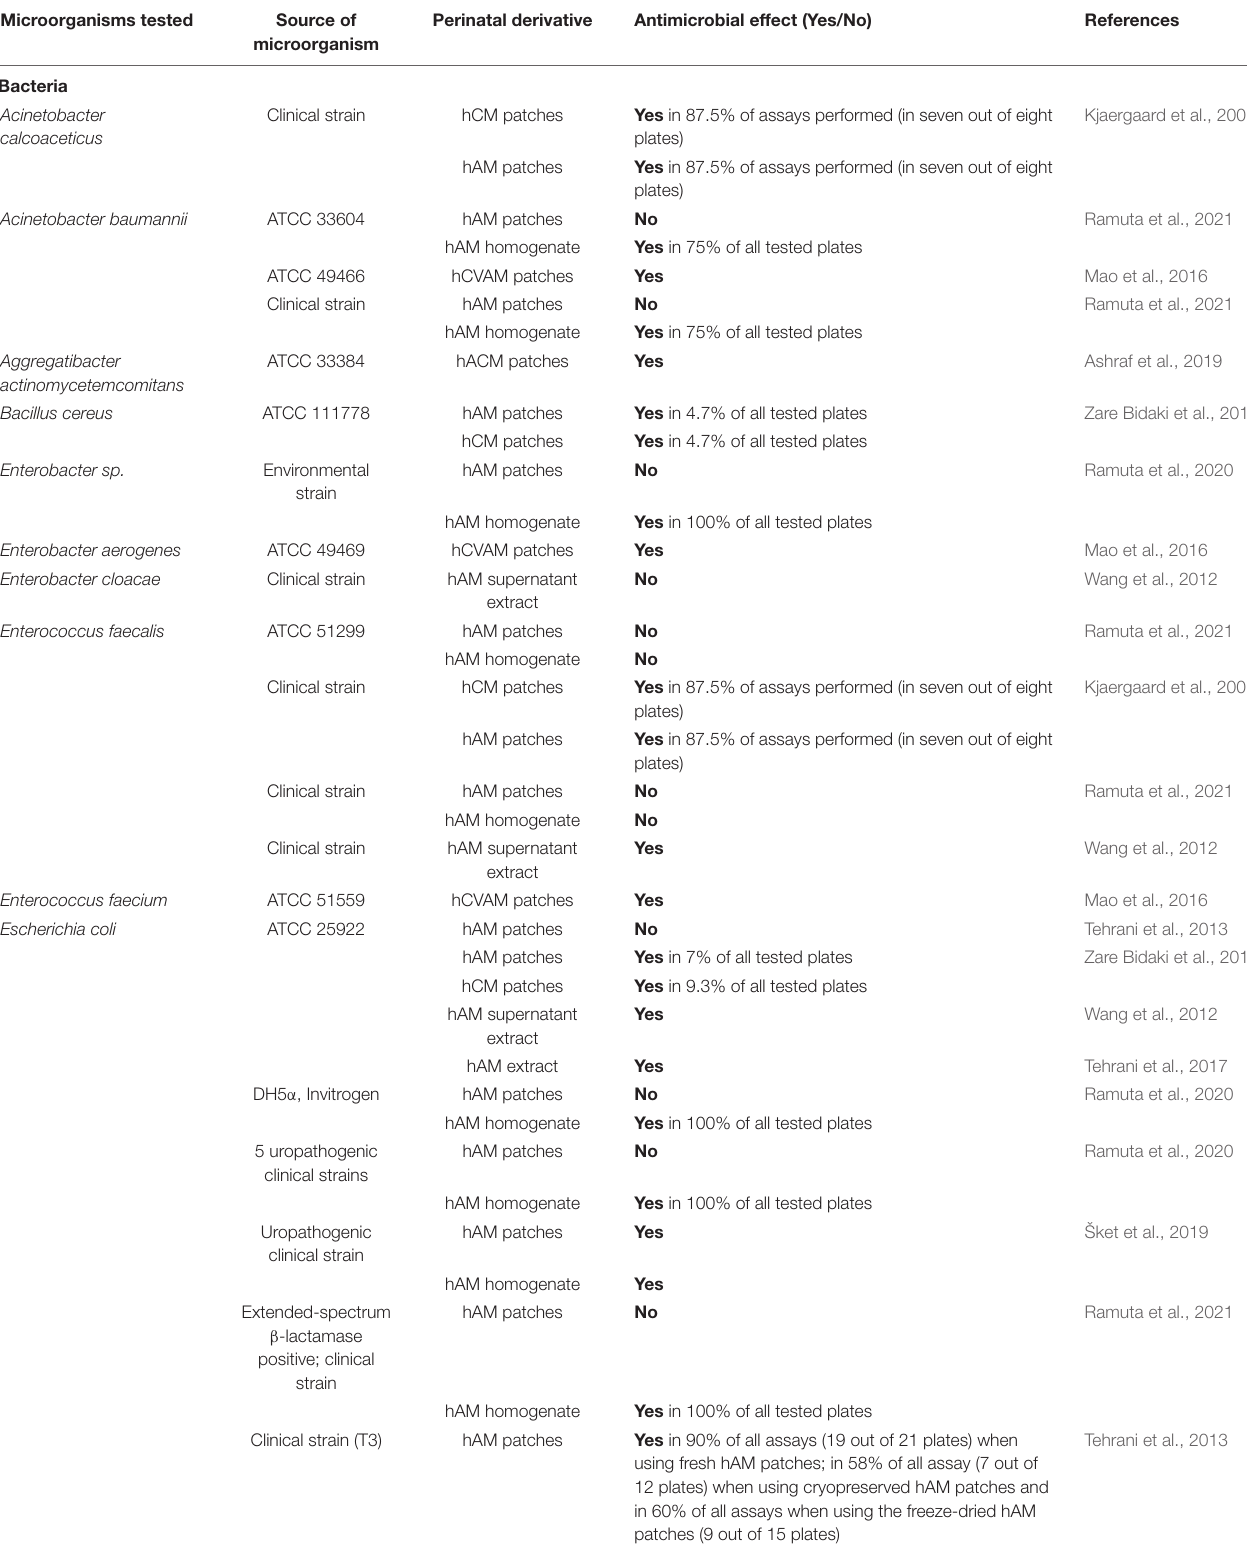
TABLE 2 | The antimicrobial effect of fetal membranes and their derivatives on various